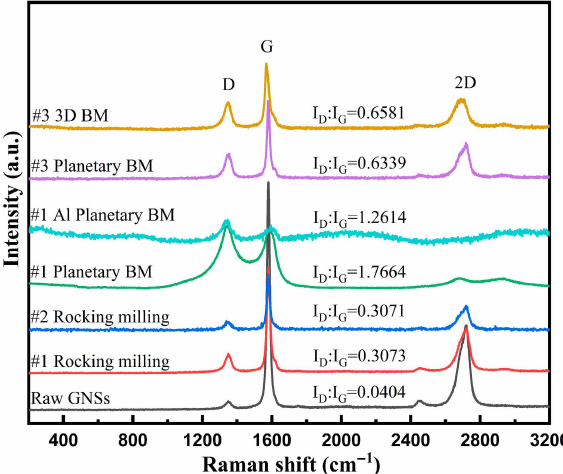
Figure 11. Raman spectra of GNSs and GNSs/metal composite